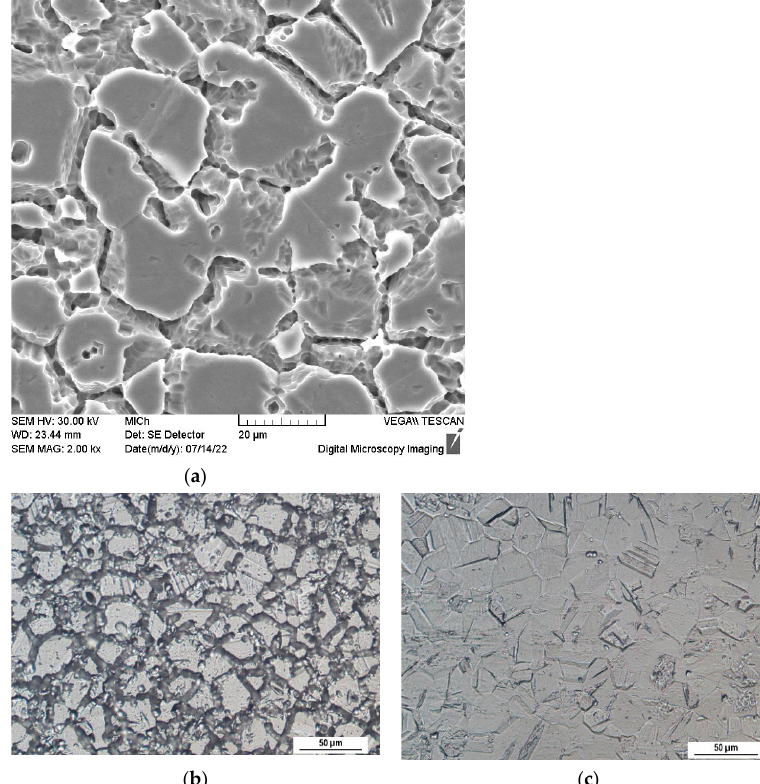
Figure 2. Microstructure of AISI 304 SS after oxalic acid electroetching according ASTM A262 practice A: ( a ) after heat exposure, SEM, magnification 2000 × ; ( b ) after heat exposure, OM, magnification 400 × ; ( c ) as received, OM, magnification 400 ×.